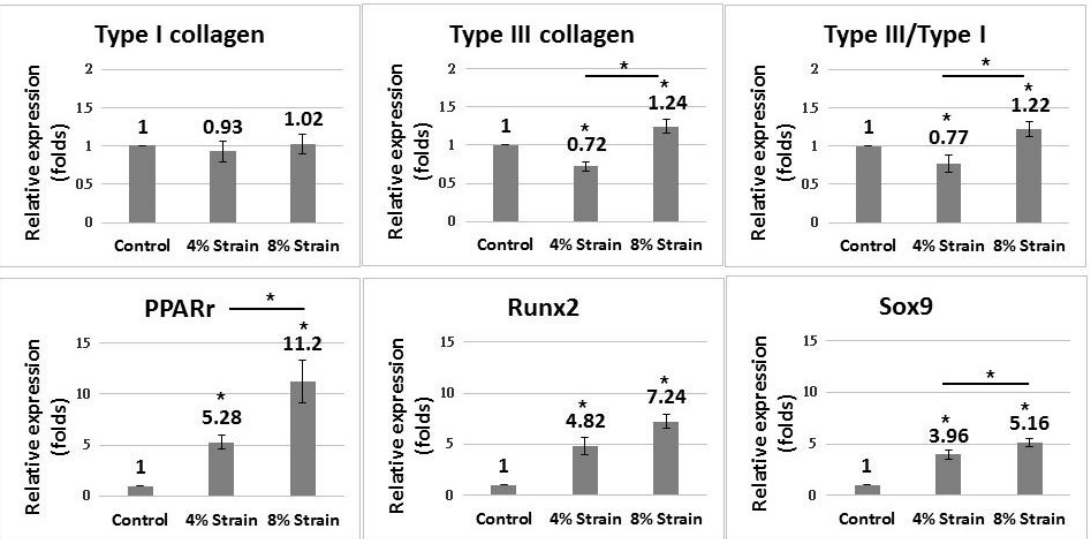
Figure 2. Quantitative PCR of tendon-derived cells (TDCs) 8 h after cyclic stretching with 4% or 8% mean strain. Upper panel : The 8% strain group showed increased gene expression of type III collagen and type III / type I collagen ratio compared with cells in the control group; the 4% strain group showed decreased gene expression of type III collagen compared with TDCs in the control group. Lower panel : Both the 4% and 8% strain groups showed increased expression of Pparg , Runx2 , and Sox9 compared with TDCs in the control group. Data are expressed in fold-changes of expression level relative to the control (static culture) and presented as mean ± SD ( n = 4, * p < 0.05).